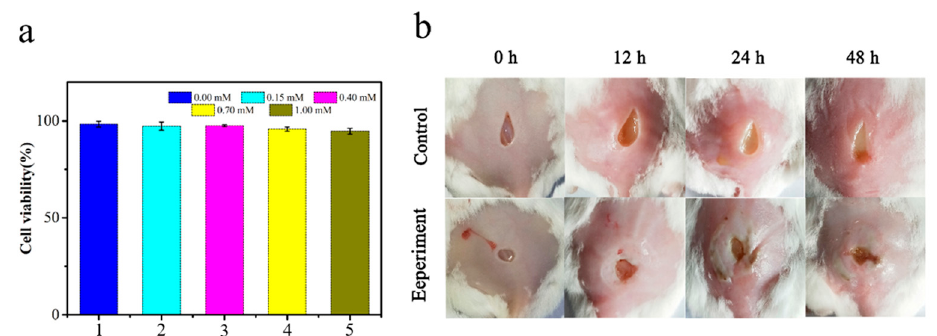
Figure 7. ( a ) Cytotoxic potential of allicin at different concentrations (1 = 0 mM, 2 = 0.15 mM, 3 = 0.40 mM, 4 = 0.70 mM, 5 = 1.00 mM) on A549 cells. ( b ) Photographs of mice wound 0 h, 12 h, 24 h, 48 h after bacterial infection.